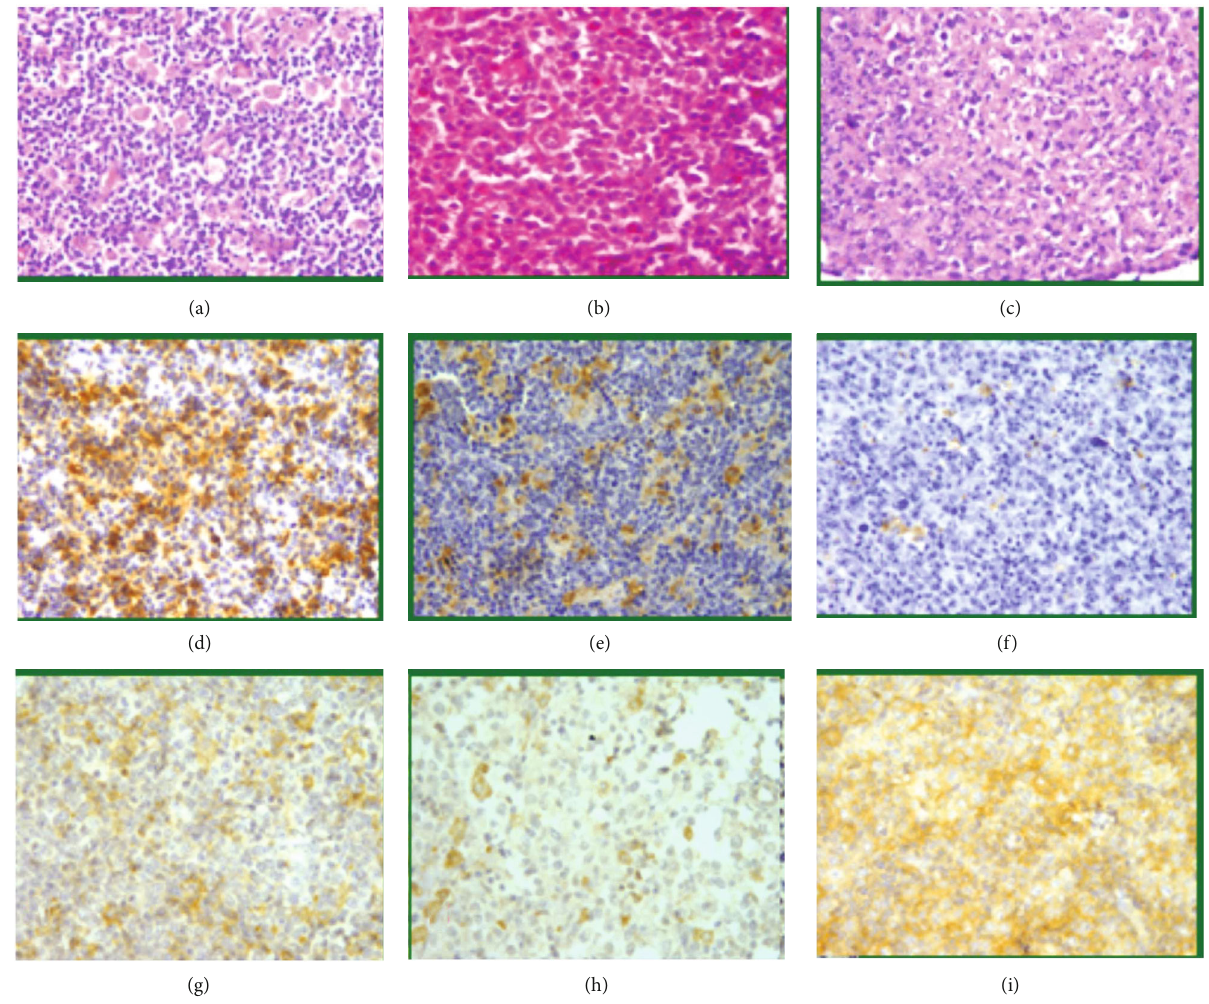
Figure 2: DLBCL with reactive appearing histocytes in the background (a – c, × 200); IHC staining for CD68 showed the variable intensity of CD68-positive histiocytic cells in the background of lymphoma cells (high, moderate, and low (d – f, respectively, × 200)). IHC for MMP9 showed the variable intensity of histocytes in the background of lymphoma cells (low, moderate, and high (g – i, respectively, ×